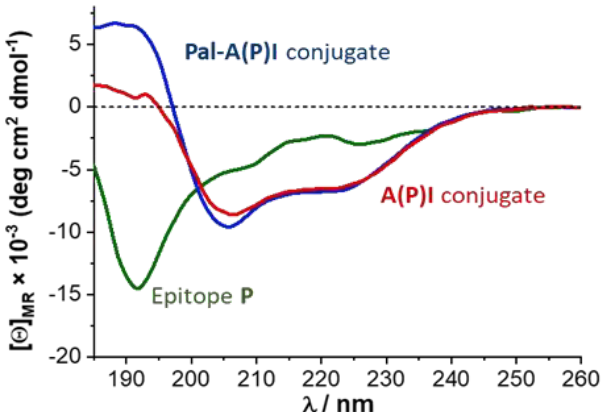
Figure 1. Electronic circular dichroism (ECD) spectra of the peptide and conjugates in trifluoroethanol (TFE).